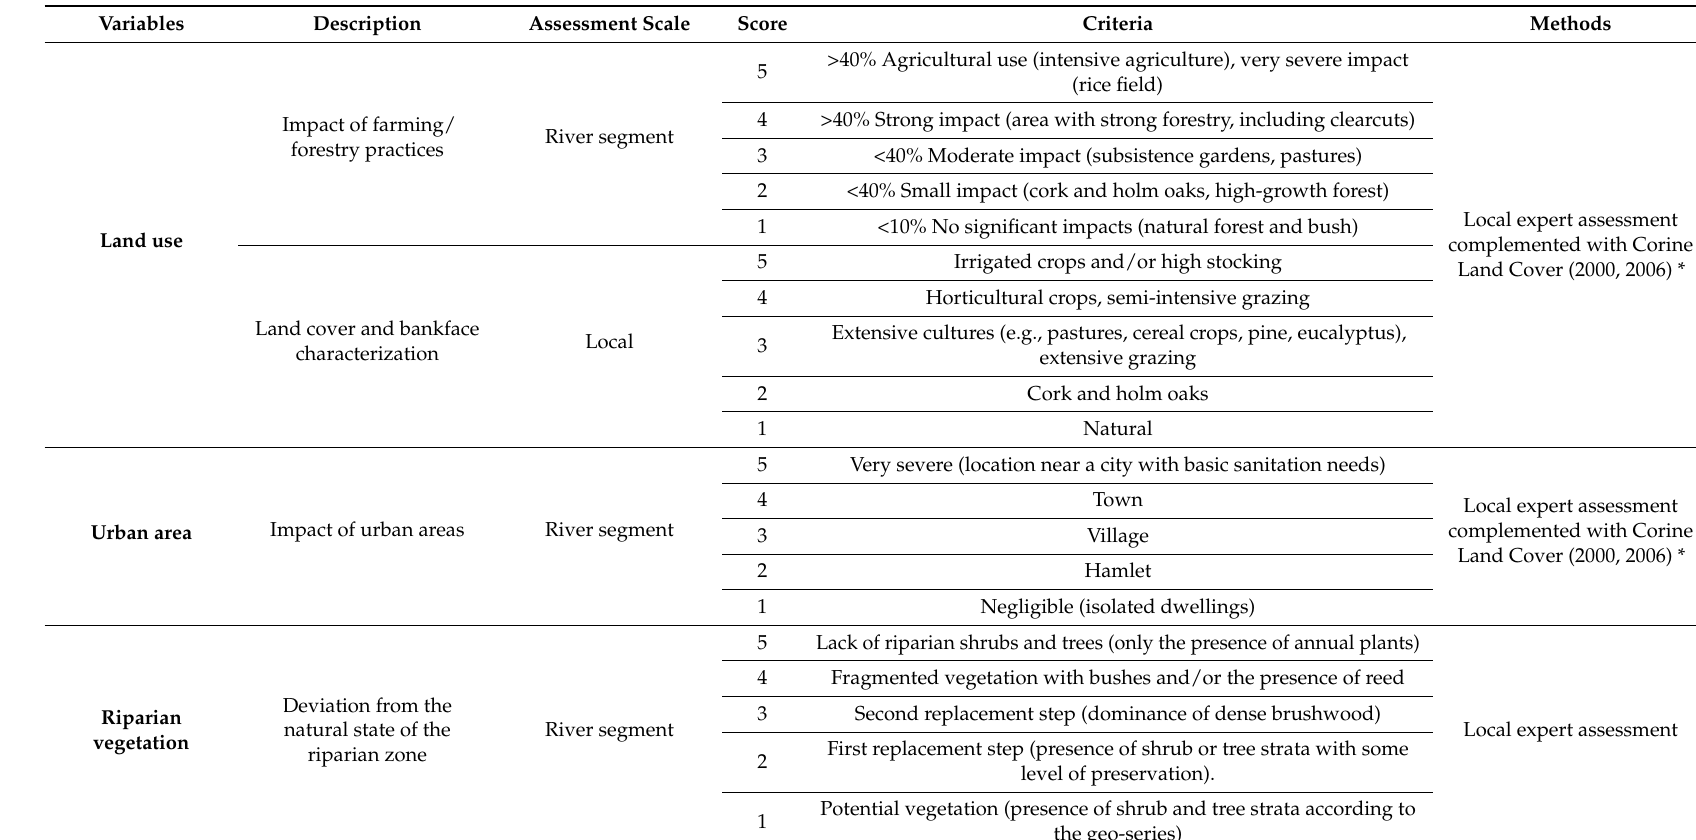
Table A1. Description, assessment scale, methods and scoring criteria of the variables used to evaluate the level of anthropogenic disturbance in each sampled site. For land use and hydrological regime, the final score results from a weighted average of the two classes of deviation